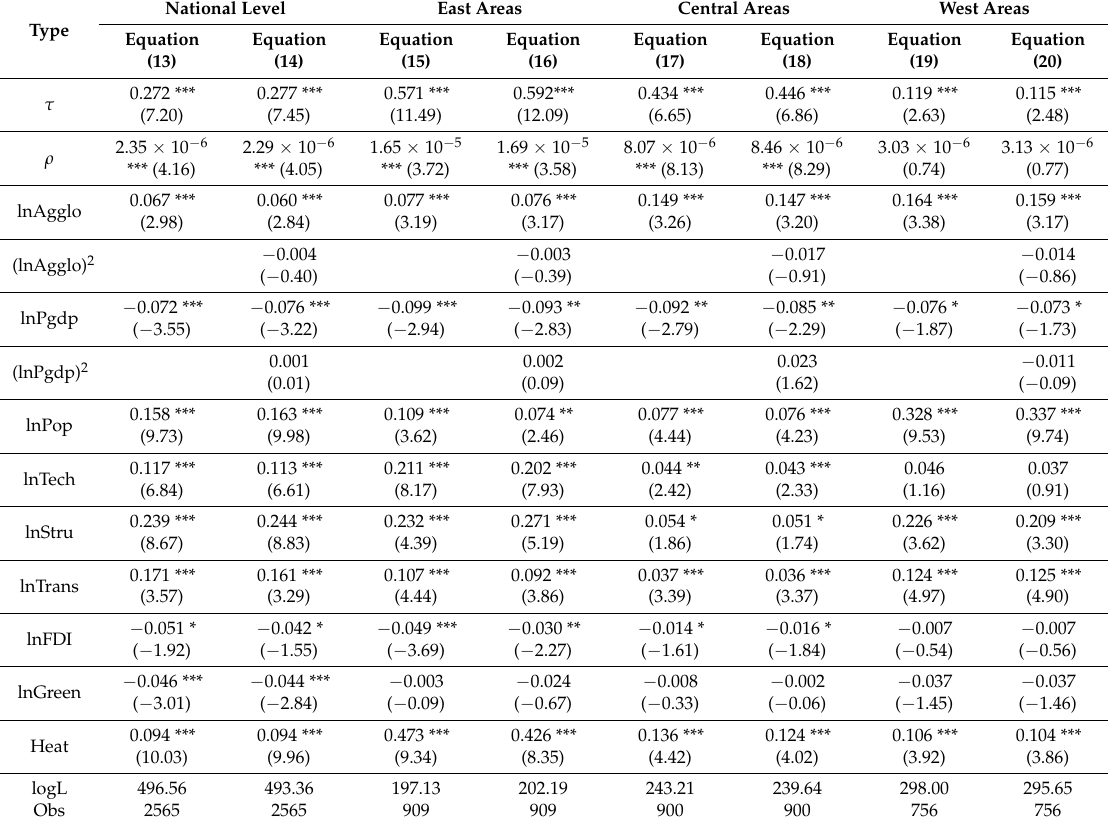
Table 5. Robustness test